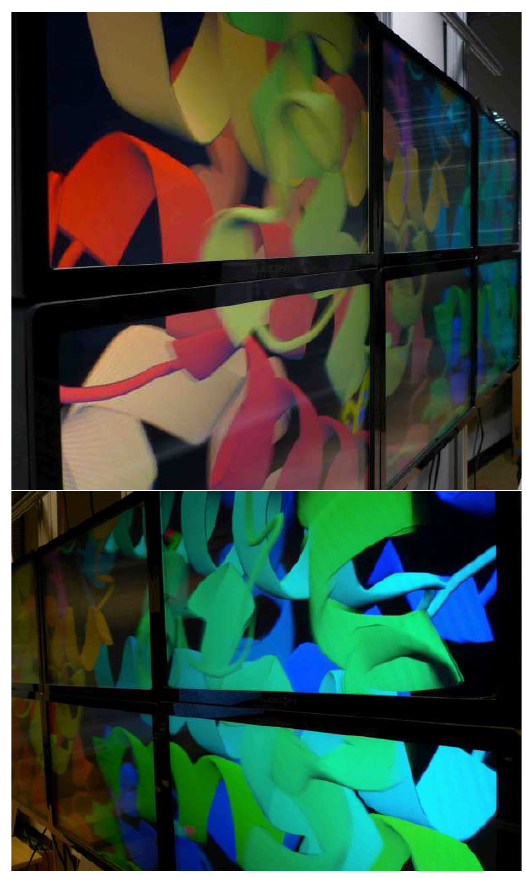
Figure 24. The Alioscopy displays used in the REVE are meant to be viewed more orthogonally than in the above pho- tographs. A cube-shaped room-sized CAVE made from LCD panels instead of projectors presents problems, such as off-axis intensity attenuation and ghosting, as well as, in this case, depth limitation. Content: UCSD Protein Data Bank. Photo: Tom DeFanti. (Stereo not turned off.)